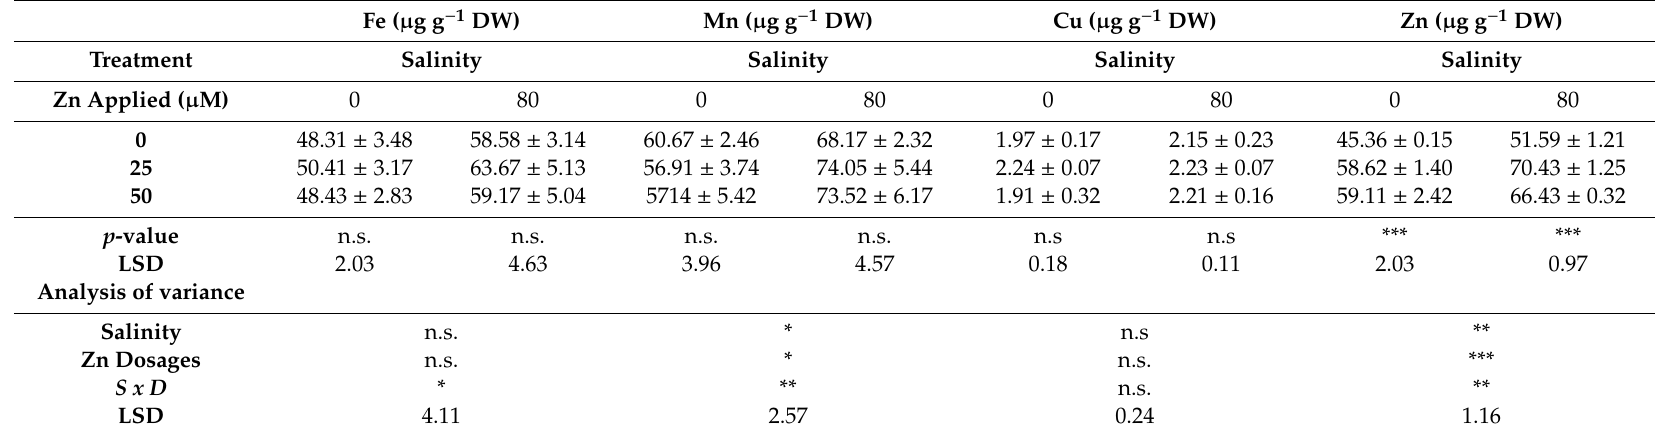
Table 3. Microelement concentrations of leaves of pak choi plants grown with di ff erent salinity and / or Zn treatments. Values are means ± SE ( n =